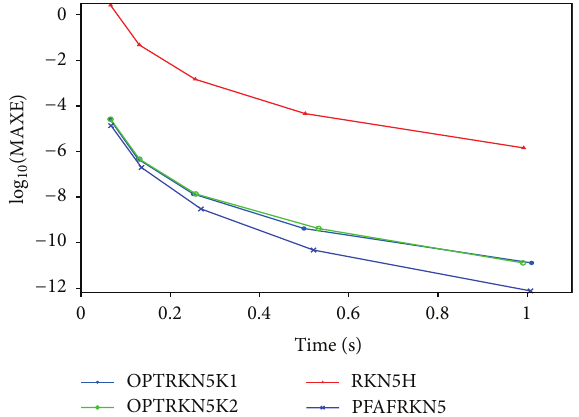
Figure14:EfficiencycurvesforallmethodsoforderfiveforProblem 3 with ℎ = 1/2 𝑖 , 𝑖 = 4,...,8 .